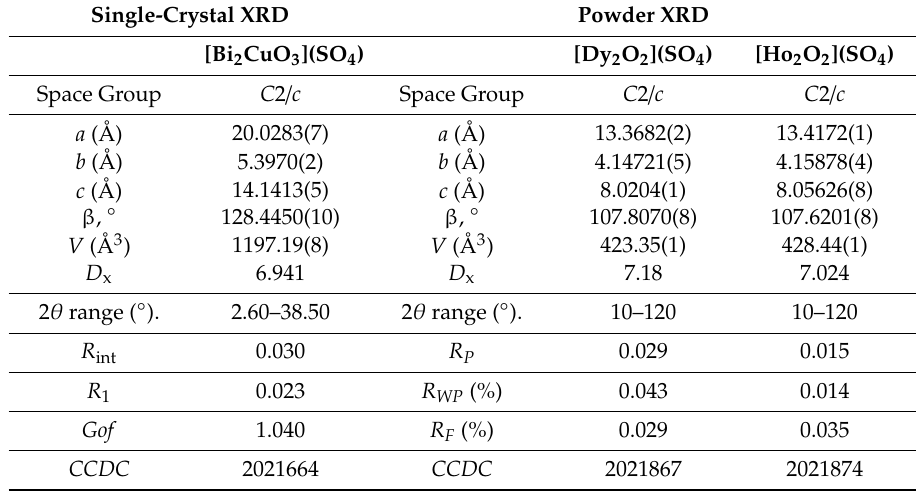
Table 1. Crystallographic data and refinement parameters for [Bi 2 CuO 3 ](SO 4 ) and [ Ln 2 O 2 ](SO 4 ) ( Ln = Dy,